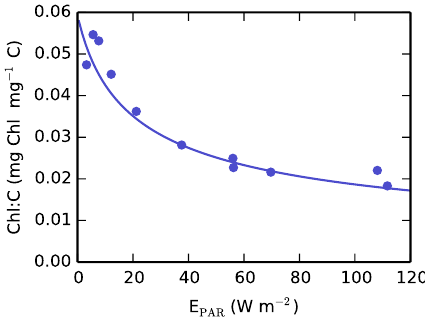
Figure 12. Chlorophyll a to carbon ratio of diatoms as a function of PAR under the condition of balanced growth (Eq. 271). The solid line represents output from the model. Black circles show data for nutrient-replete cultures of Thalassiosira pseudonana , digitally ex- tracted from Geider et al. (1997) using Plot Digitizer Version 2.6.6 (see